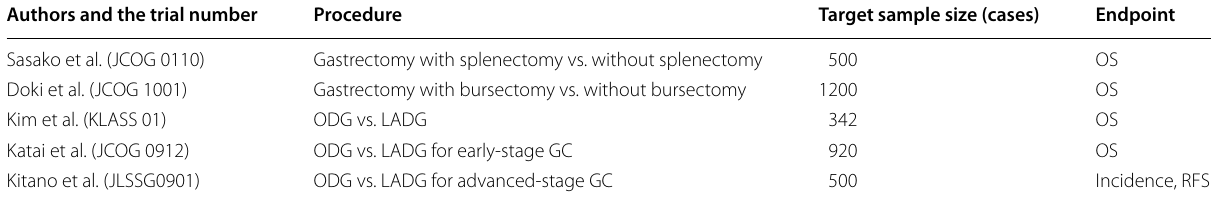
Table 3 Ongoing randomized trials of GC surgery techniques